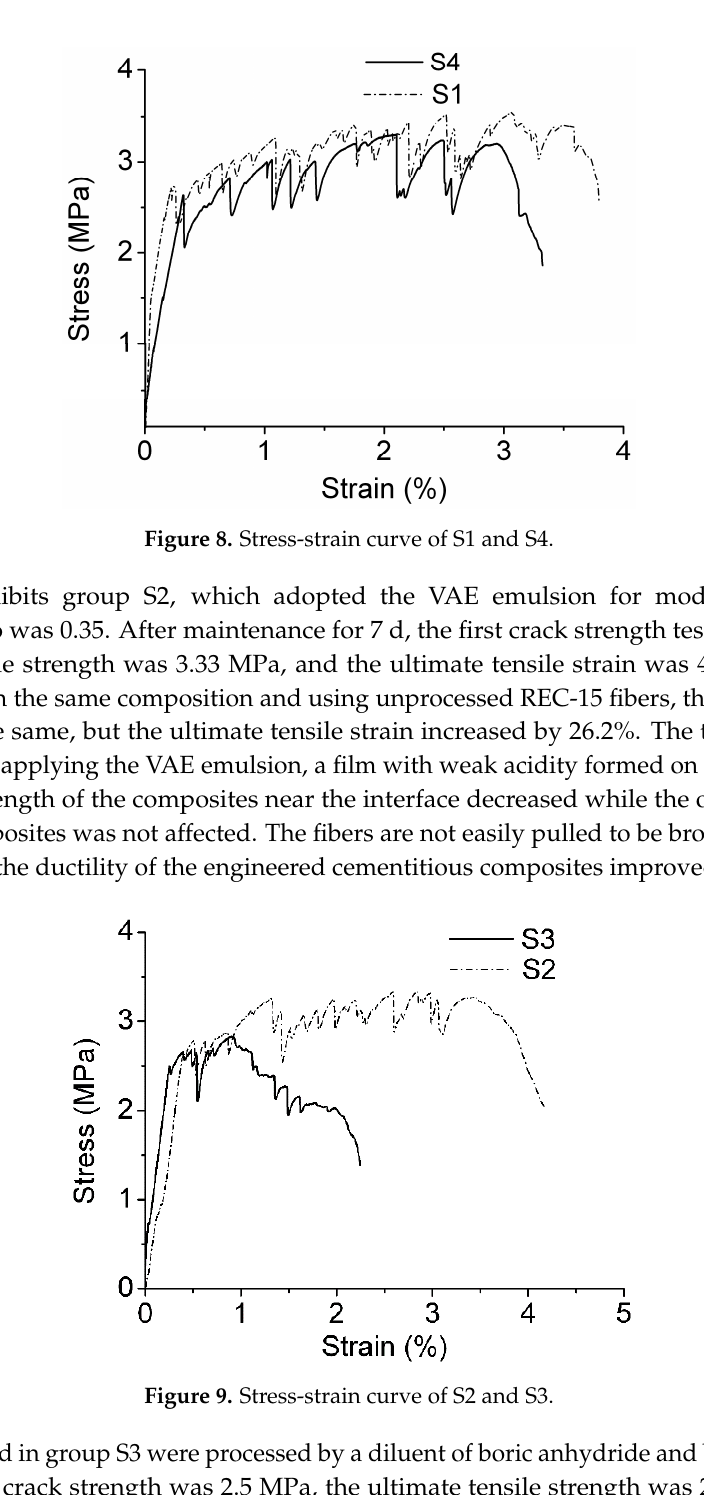
Table 11. Tensile properties of S4 and S2.